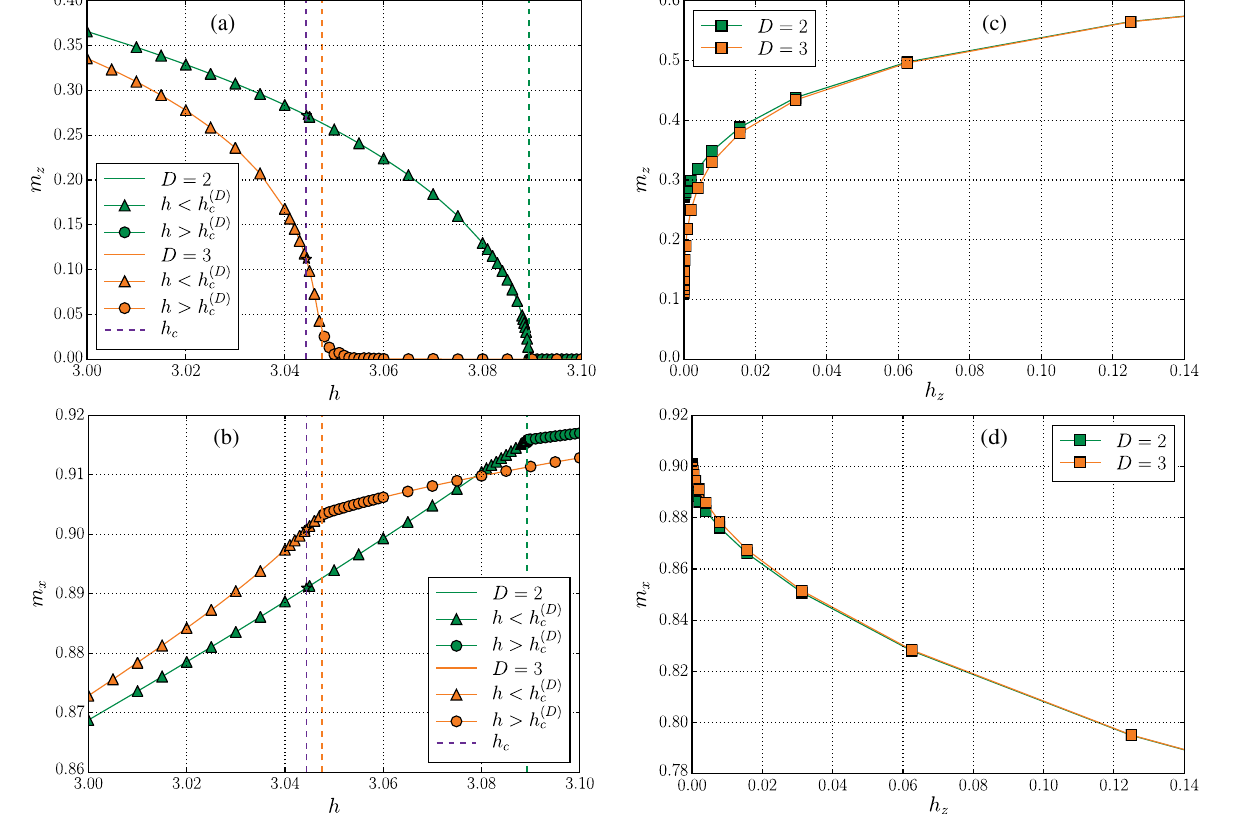
FIG. 2. iPEPS results for the magnetizations per site m z ¼ jh σ z i ij and m x ¼ h σ x i i as a function of h ( h z ¼ 0 ) in (a) and (b) and as a function of h z ( h ¼ h c ) in (c) and (d). Result for iPEPS bond dimension D ¼ 2 , 3 are shown. The vertical dashed lines indicate the ð D Þ critical values of h c for both D values, as well as the literature reference for h c